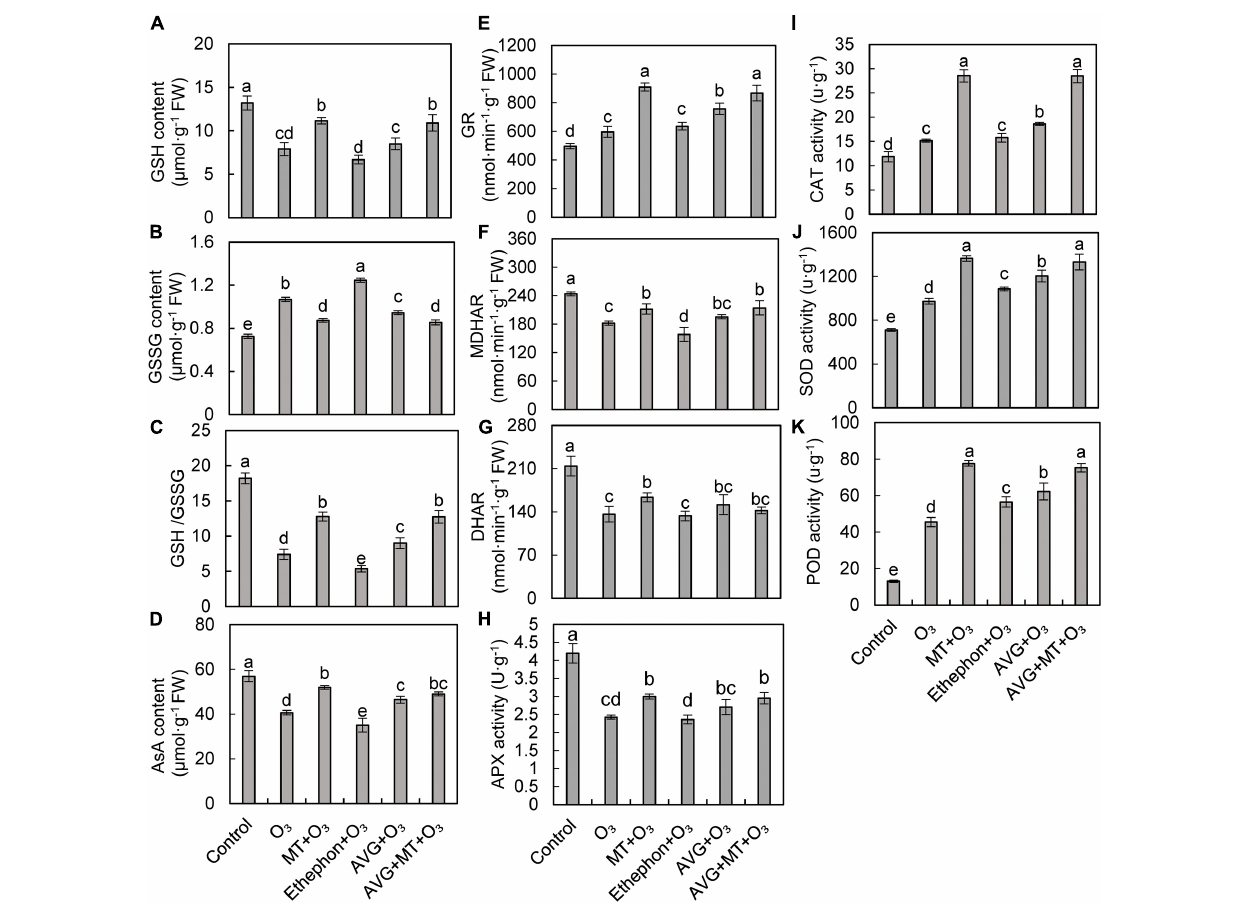
FIGURE 4 | Effects of O 3 , MT + O 3 , Ethephon + O 3 , AVG + O 3 , and AVG + MT + O 3 treatments on reduced glutathione (GSH, A ) and oxidized glutathione (GSSG, B ) contents, GSH/GSSG (C) , reduced ascorbic acid (AsA, D ) content, glutathione reductase (GR, E ), monodehydroascorbate reductase (MDHAR, F ), dehydroascorbate reductase (DHAR, G ), ascorbate peroxidase (APX, H ), catalase (CAT, I ), superoxide dismutase (SOD, J ), and peroxidase (POD, K ) activities in “Cabernet Sauvignon” grape leaves. Values represent the mean of three replicates ± SD. For the values labeled with the same lowercase letter, the difference was not significant, according to Duncan’s multiple range test at a 5% significance